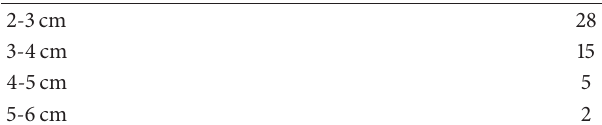
Table 2: Size of lesions.